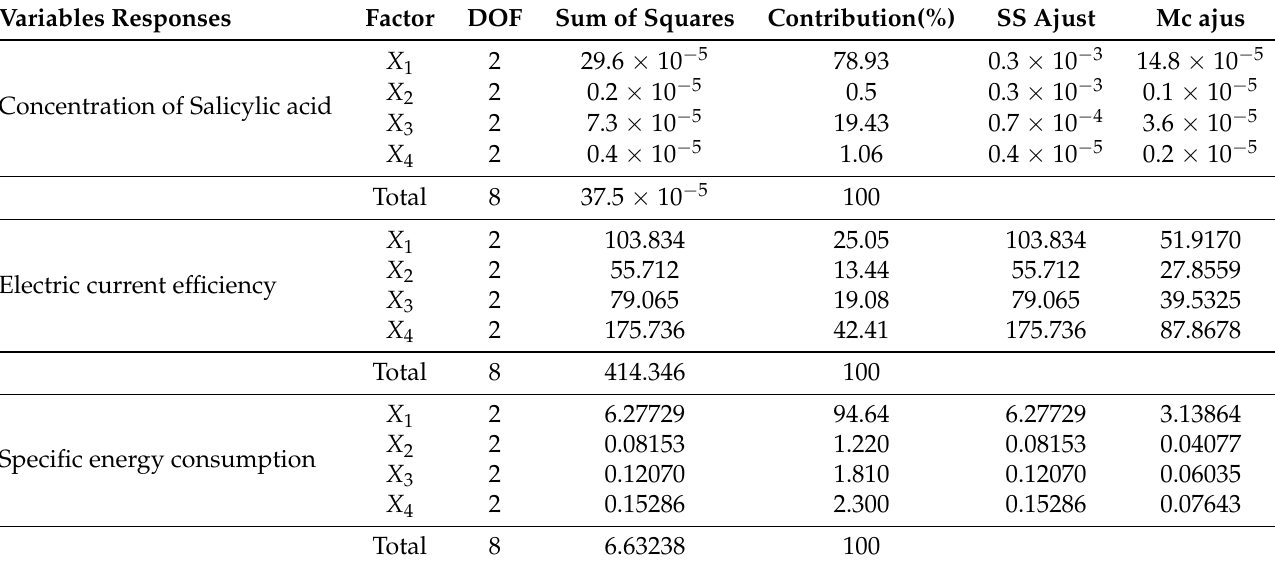
Table 5. ANOVA for acid concentration, electrical efficiency and energy